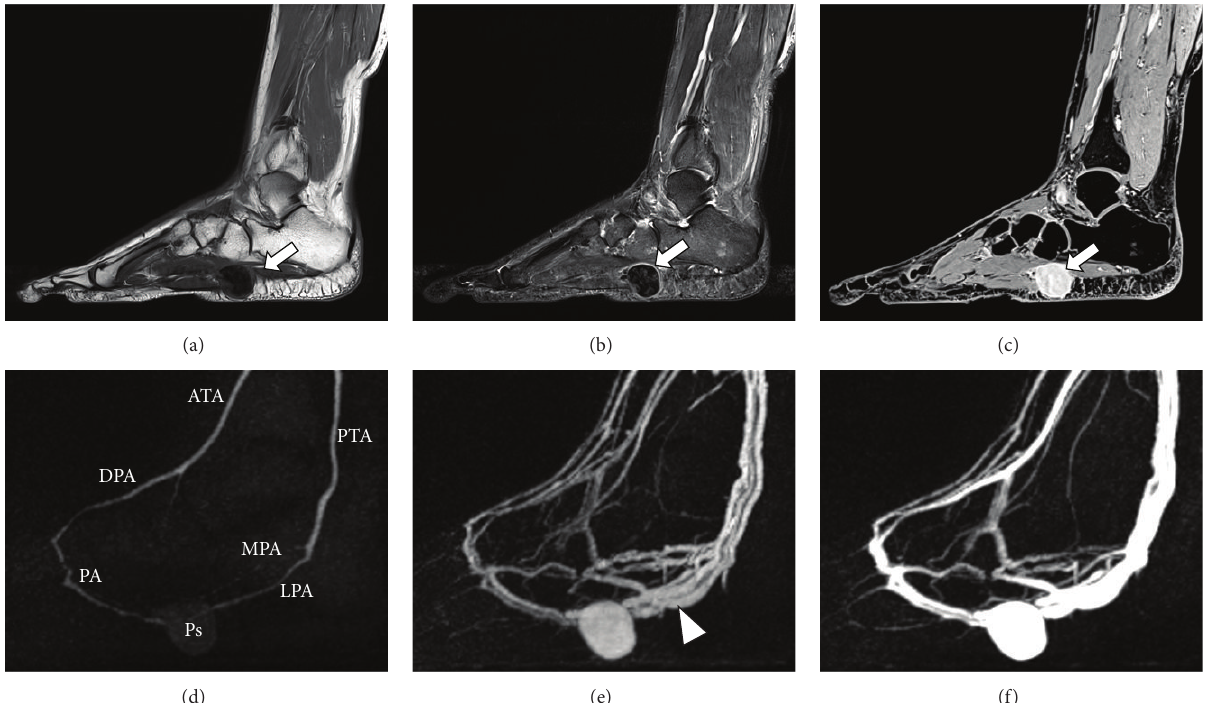
Figure 1: MRI and MRA two months after the trauma (3T Magnetom Skyra, Siemens AG Healthcare, Erlangen, Germany). (a) T1 image. (b) STIR (short-Ti inversion-recovery) image. (c) Gadolinium-enhanced VIBE (volumetric interpolated breath-hold examination) image using 6mL Gadovist (Bayer Schering, Berlin, Germany). (d)–(f) TWIST (time-resolved angiography with interleaved stochastic trajectories) 3D MRA with a temporal resolution of 5 seconds. White arrow = pseudoaneurysm. White arrowhead = early filling of the veins due to arteriovenous fistula. ATA = anterior tibial artery. DPA = dorsalis pedis artery. PA = plantar arch. MPA = medial plantar artery. LPA = lateral plantar artery. PTA = posterior tibial artery. Ps = pseudoaneurysm of the lateral plantar artery.